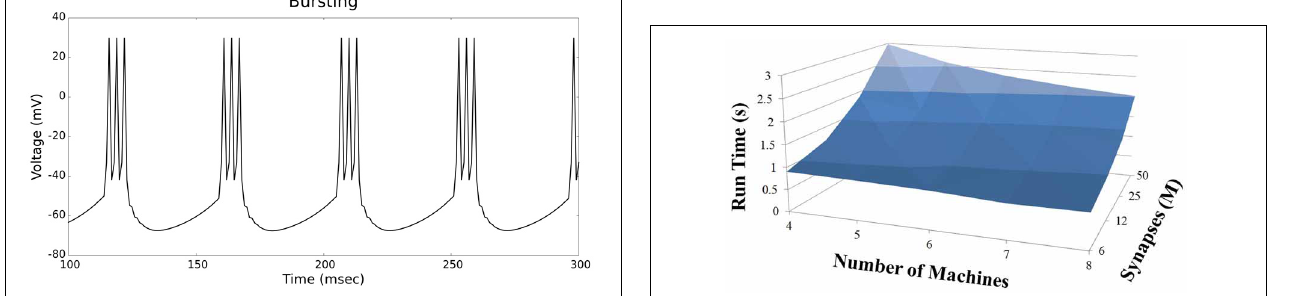
FIGURE 8 | LIF neuron model: bursting firing patterns.